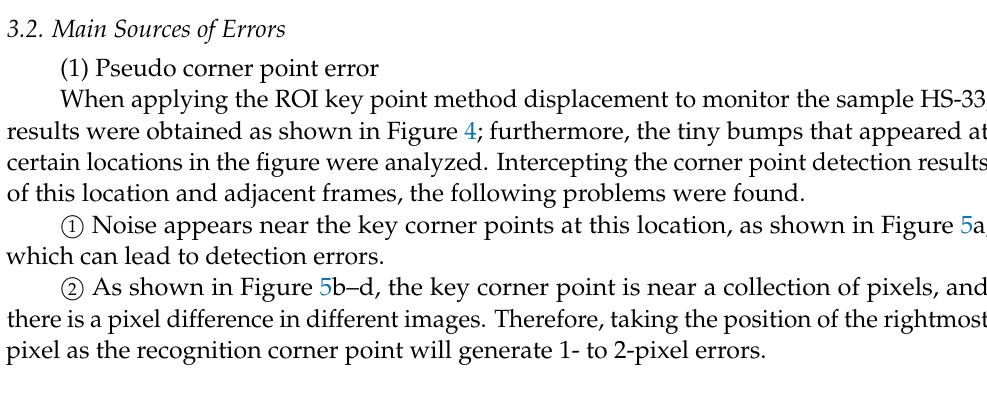
Figure 3. Experimental scene.